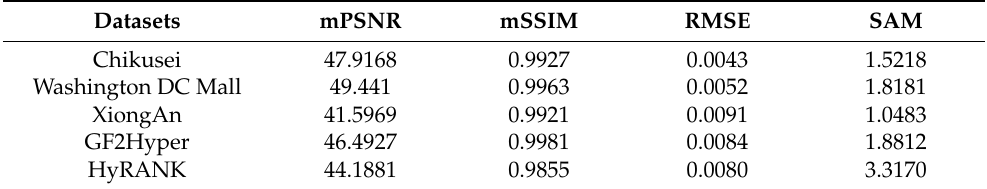
Table 3. Quantitative results of pre-trained model by random masking strategy with 75% masking rate. The model is trained with a 75% masking rate.